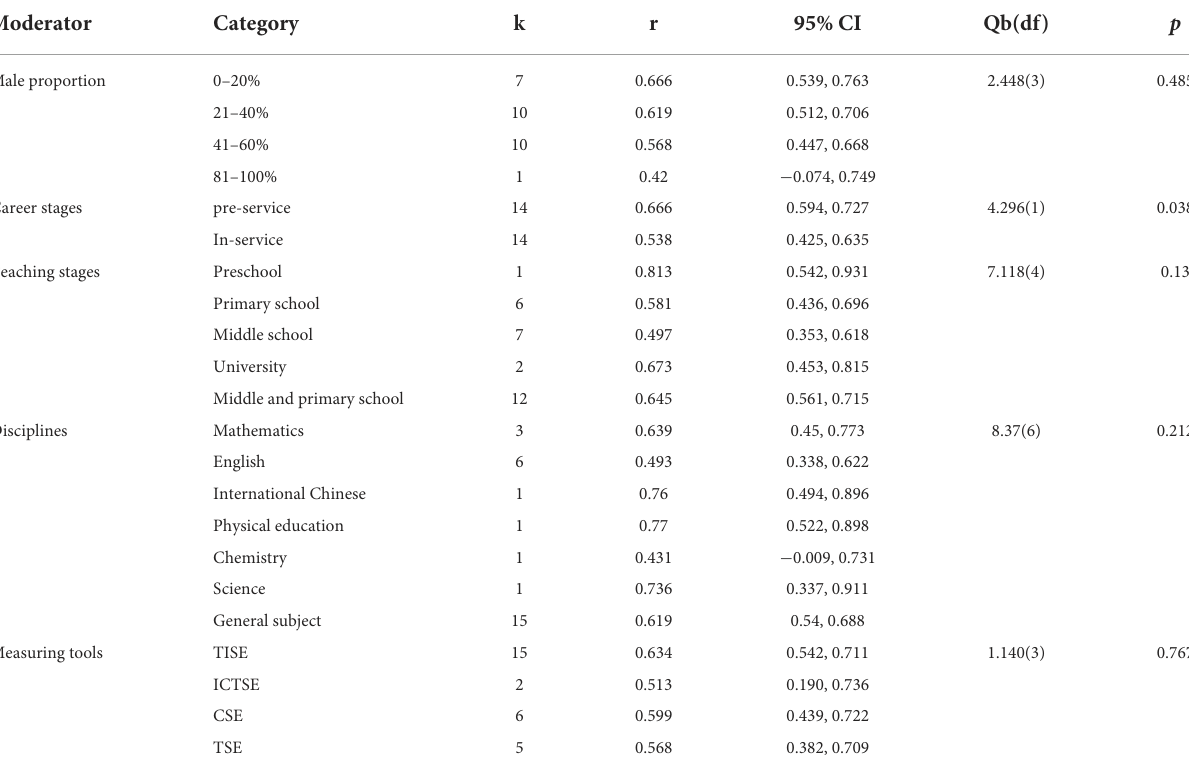
TABLE 2 The moderating effect of the relationship between teachers’ information technology integration self-efficacy and